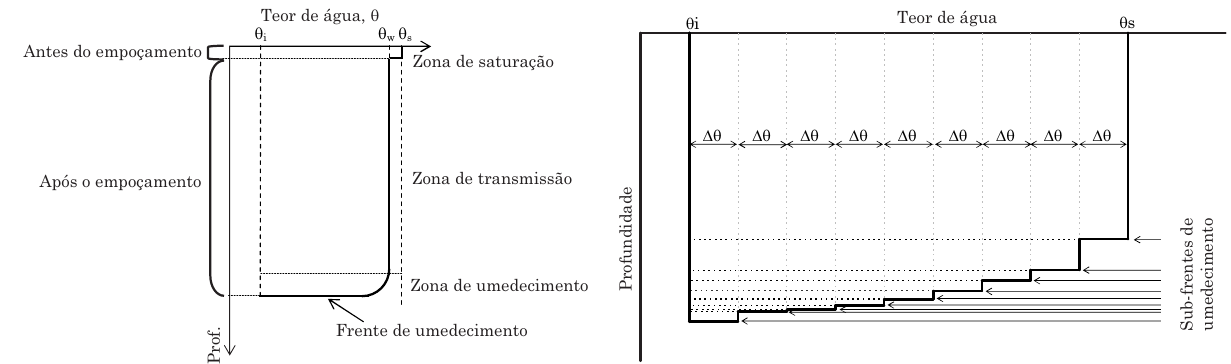
Figura 1. Perfil de umedecimento do solo considerado no GAML-c: teórico (a) e discretizado